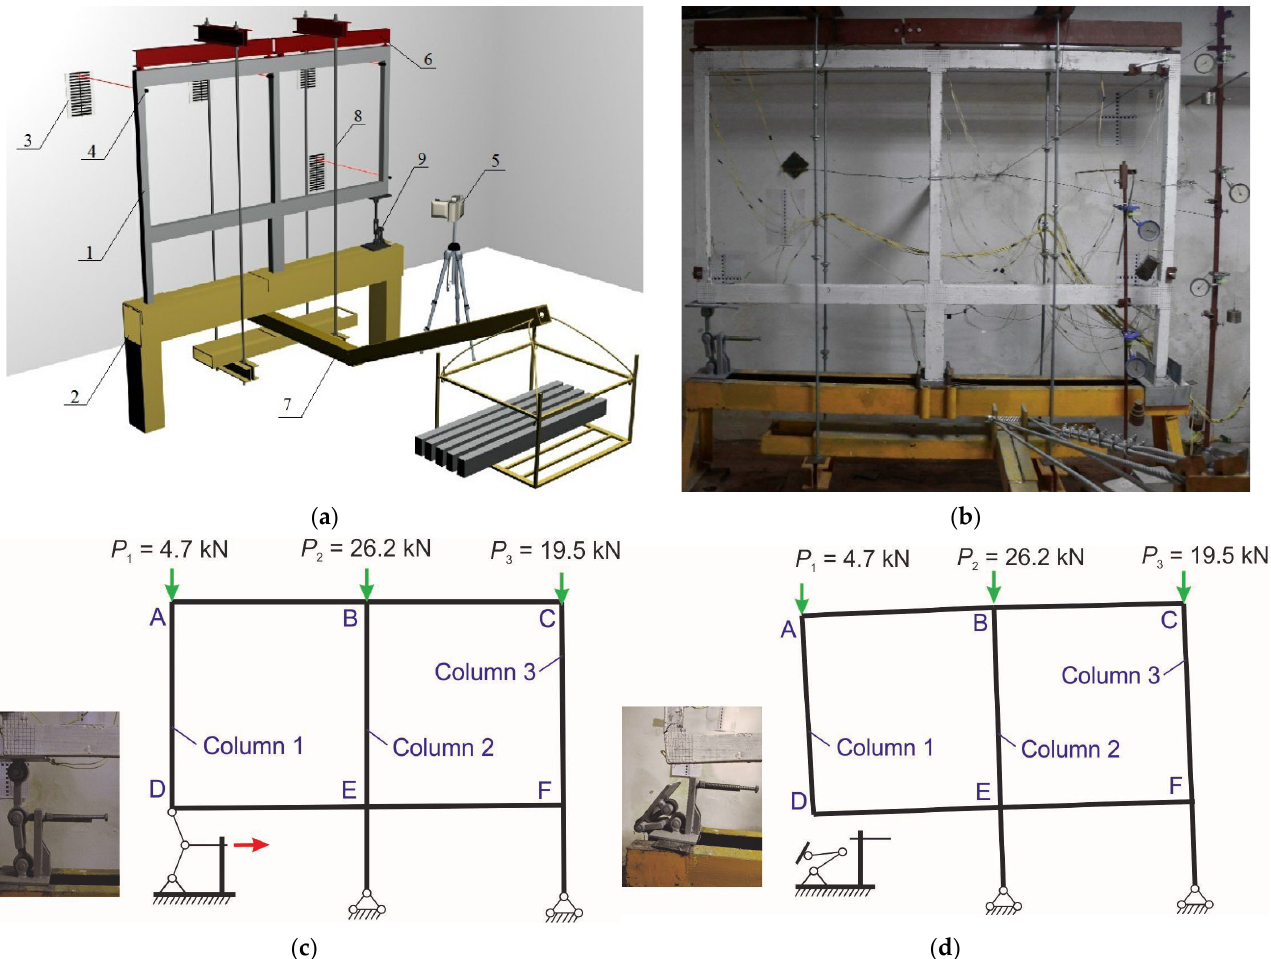
Figure 4. Test bench scheme ( a ); general view of the test bench ( b ); design scheme of the reinforced concrete frame in the first ( c ) and second stages of testing ( d ): 1—scaled reinforced concrete frame; 2—power frame; 3—graduated scale; 4—laser pointer; 5—video camera; 6—distribution beam; 7—leverage; 8—strands; 9—the device used to simulate the corner column.